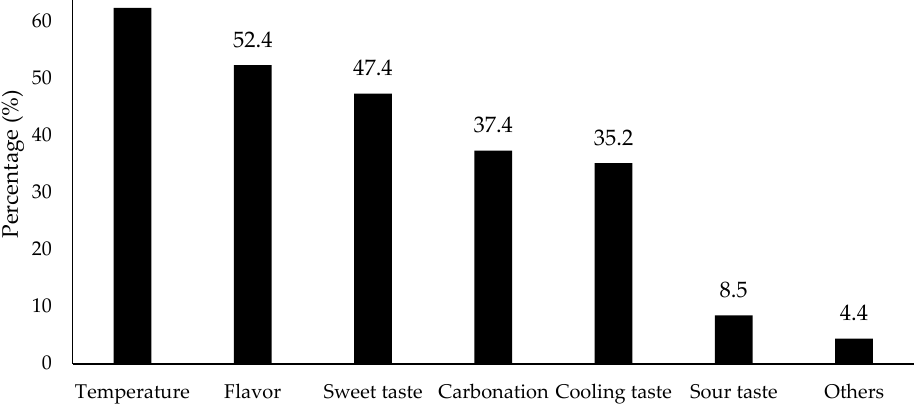
Figure 4. Percentage (%) for the factors that consumers considered the most when deciding to drink flavored water/beverages ( n = 901). Others included caffeine, sugar free, thirst-quenching ability, calories, price, convenience, nutrition facts, artificial taste, health benefits, and organic ingredients according to the collected